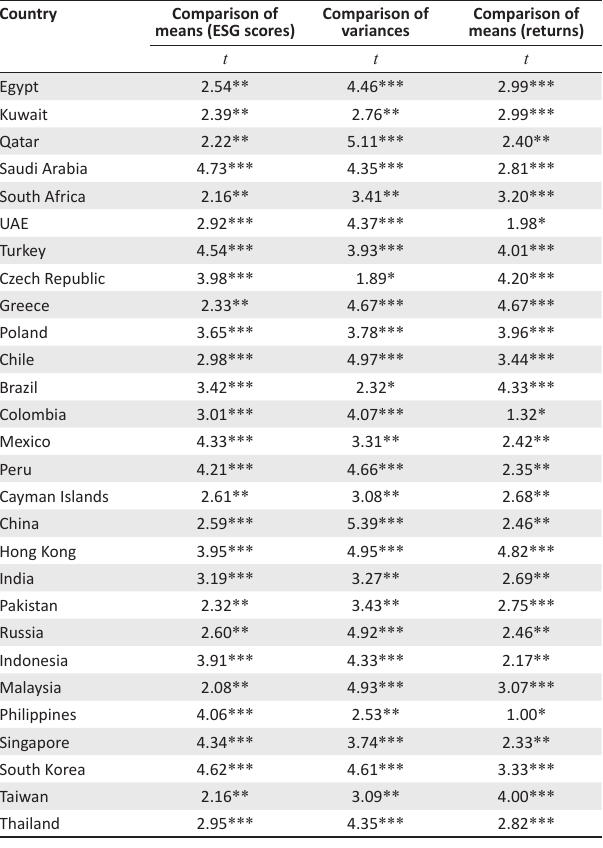
TABLE 1-A1: t statistics for comparison of ESG means, variances and return means. Country Comparison of means (ESG